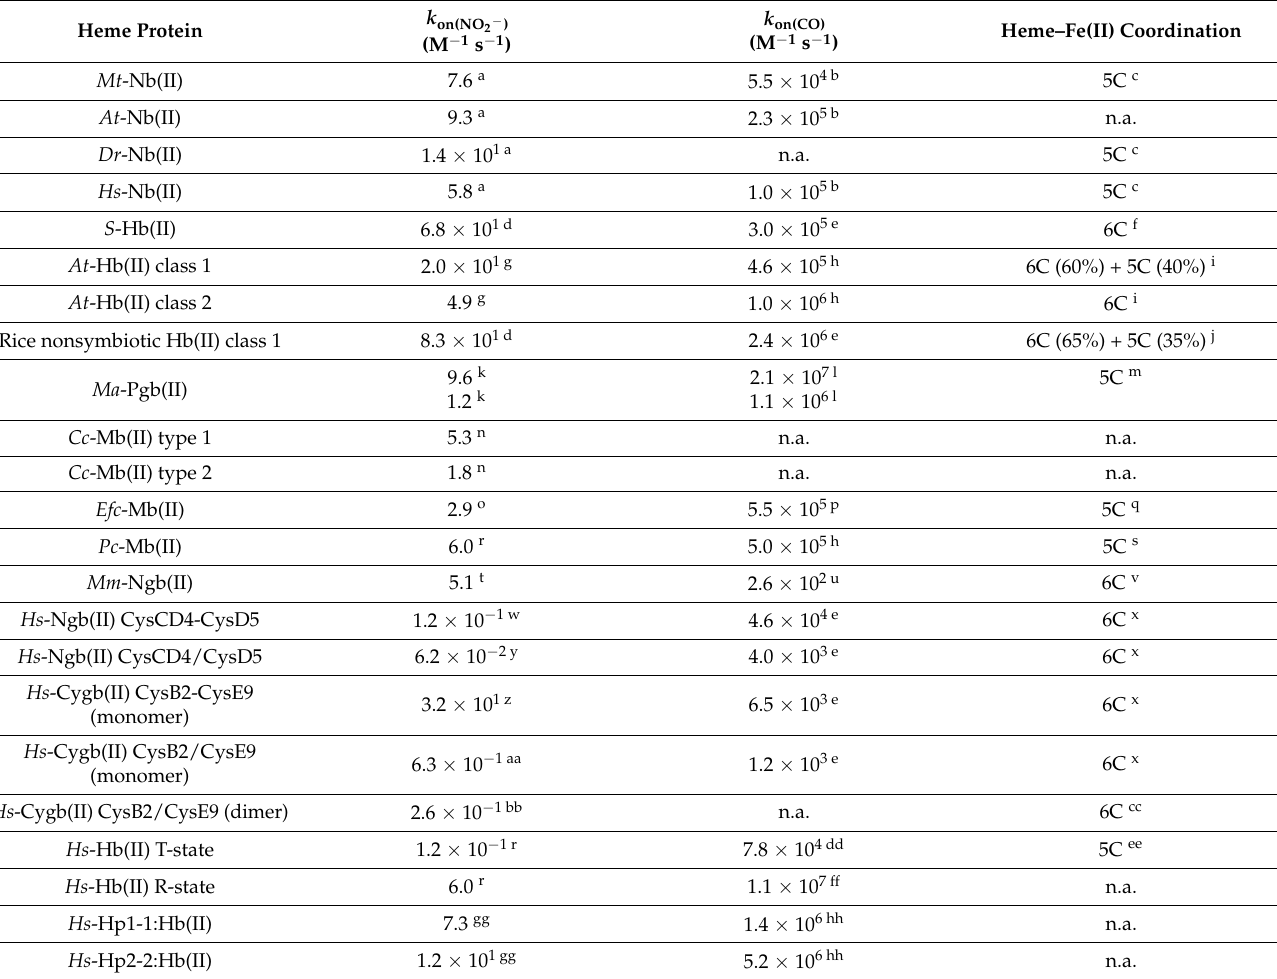
Table 1. Values of the second-order rate constants for the nitrite reductase activity and carbonylation of ferrous heme proteins as well as heme–Fe